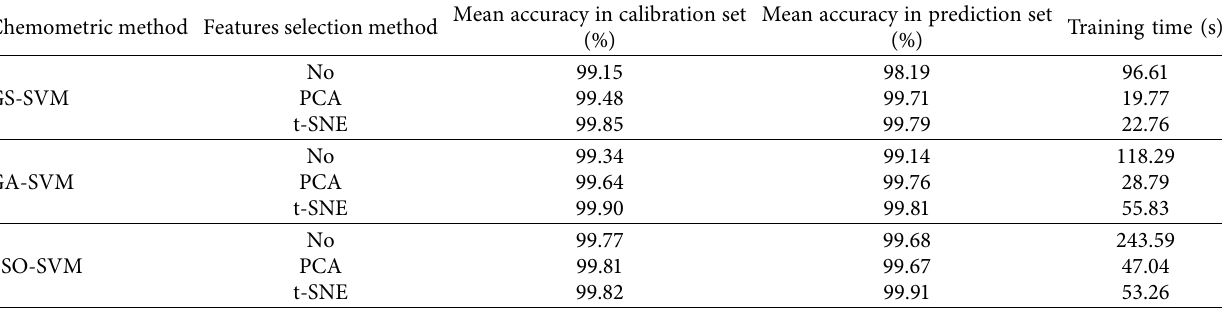
Figure 6: Fitness curve of PSO. (a) Fitness curve of No-PSO-SVM (best c � 0.1, g � 0.1, and CVAccuracy � 100%). (b) Fitness curve of PCA- PSO-SVM (best c � 10.2413, g � 0.60183, and CVAccuracy � 100%). (c) Fitness curve of t-SNE-PSO-SVM (best c � 12.591, g � 0.1, and CVAccuracy � 100%). Table 3: Identification results of all chemometric